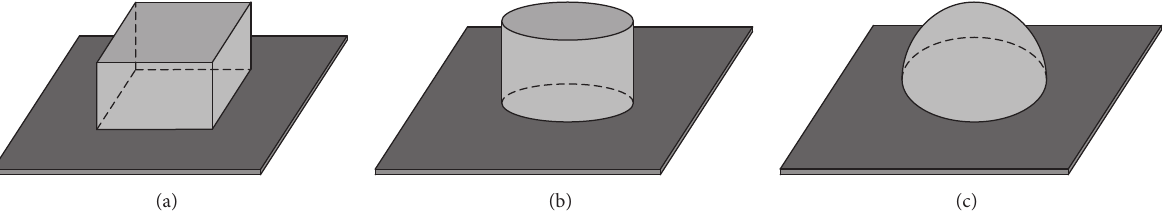
Figure 45: Rectangular (a), cylindrical (b), and hemispherical (c) DRA on a metallic ground